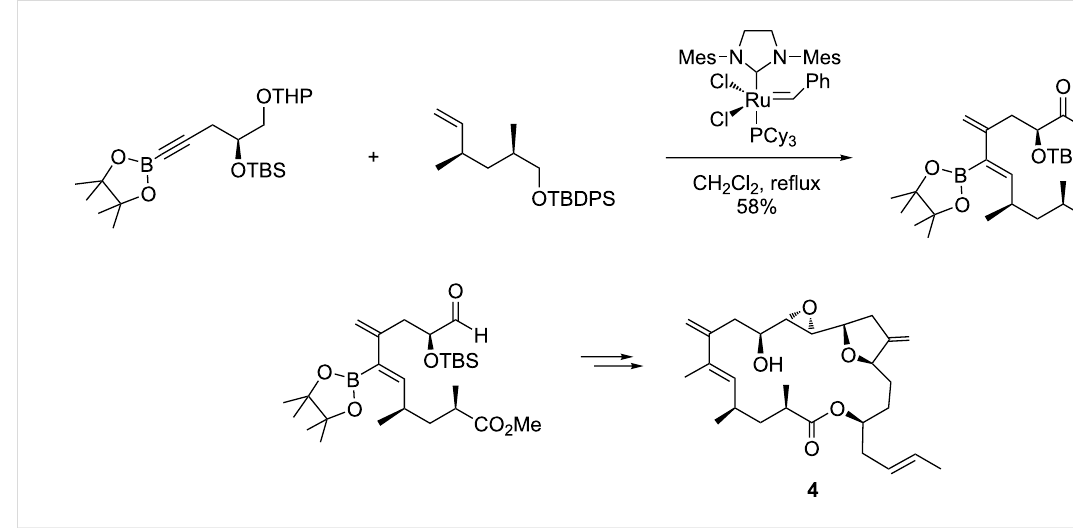
Scheme 7: Synthesis of amphidinolide K ( 4 ) by an enyne metathesis route.